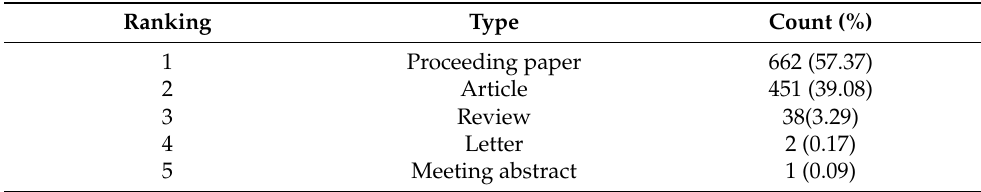
Table 1. Document types for publications referencing electric power wheelchair (EPW) human- machine interaction (HMI)